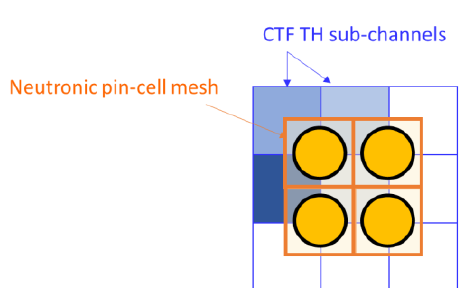
Figure 2. Principle of spatial